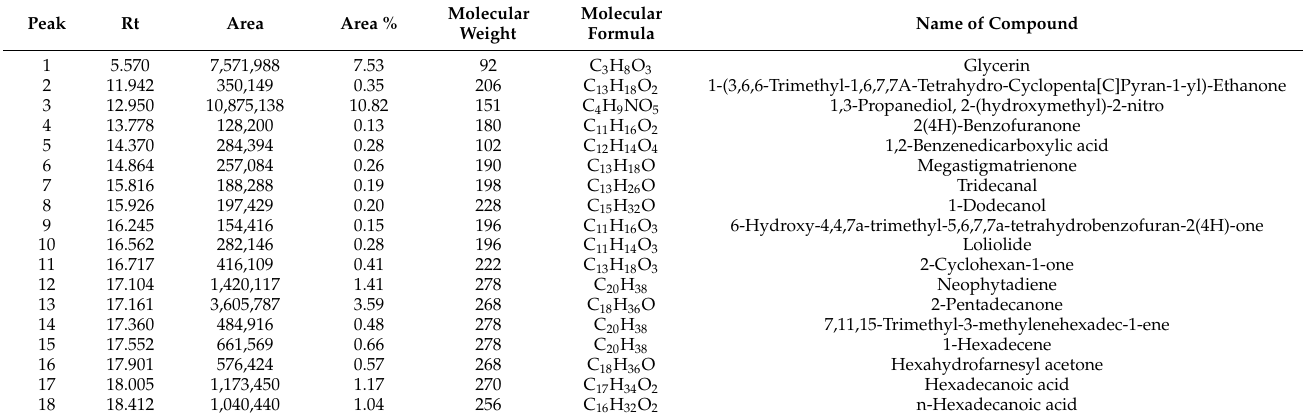
Table 7. Phytoconstituents detected in methanol leaf extract of in vitro-propagated D. palmatus plants. Peak